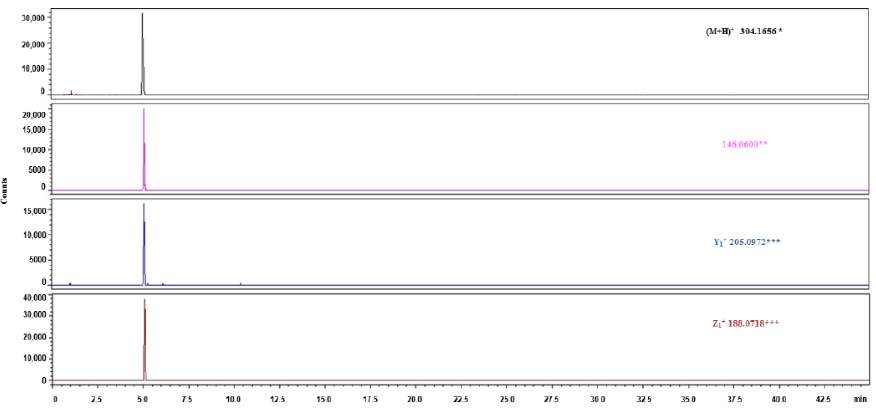
Figure 3. RP-HPLC-MS/MS chromatogram of the multifunctional peptide VW (DPP-IV and ACE inhibitory activity and antioxidant activity), including ion mass/charge ratios, identified in oat kernels proteins digest; * m/z of precursor ion, ** m/z of the ion present in the spectrum from the METLIN database, *** type of ion and m/z of the daughter ion.